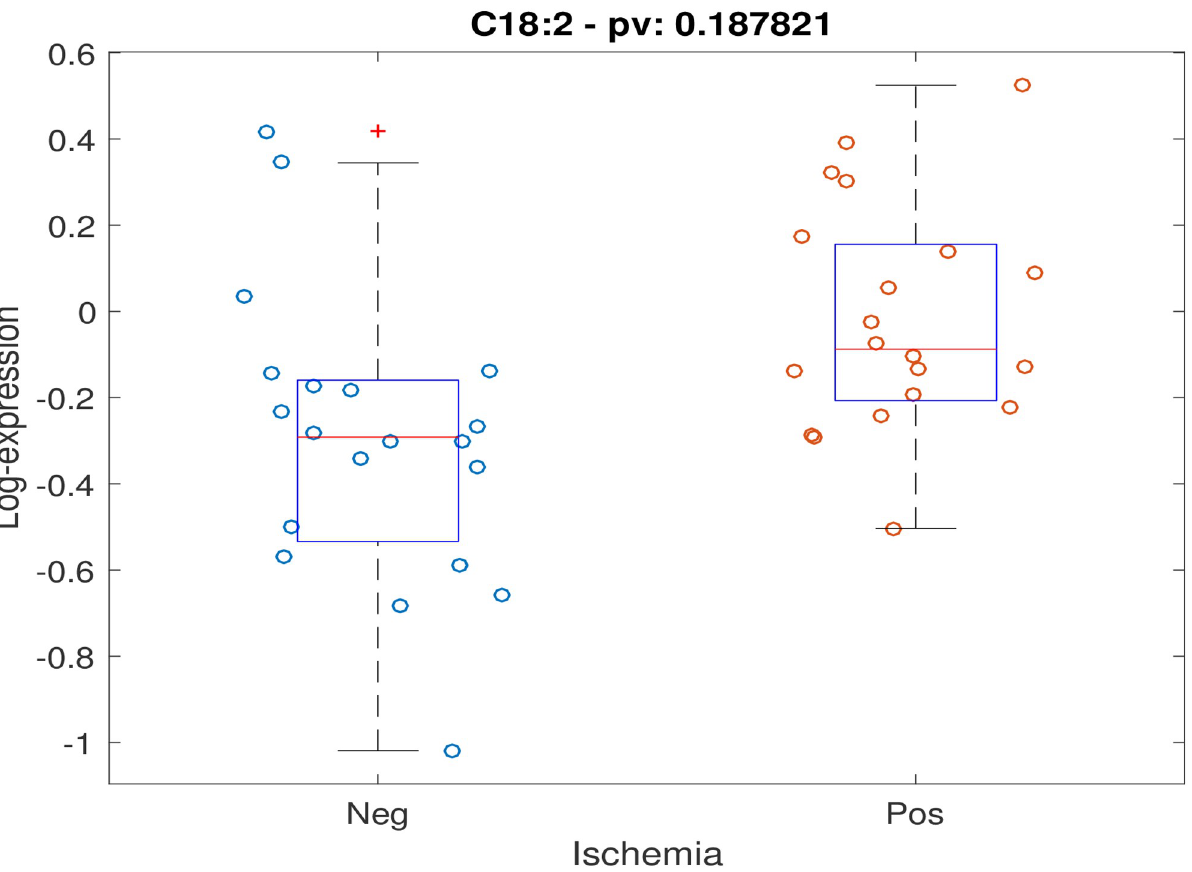
Fig 2. Scatter plot of stress-delta in C18:2 for patients who were positive versus negative for ischemia. When assessing changes in metabolite levels across timepoints while controlling for age, gender and BMI, 5 metabolites had FDR < 0.2: alanine, C14:1-OH, C16:1, C18:2, C20:4.